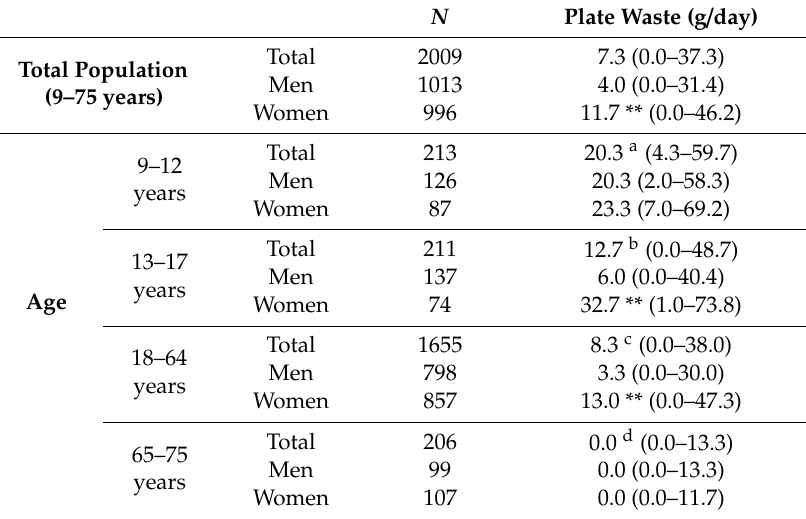
Table 2. Household and out-of-home plate waste generated by the ANIBES study population.